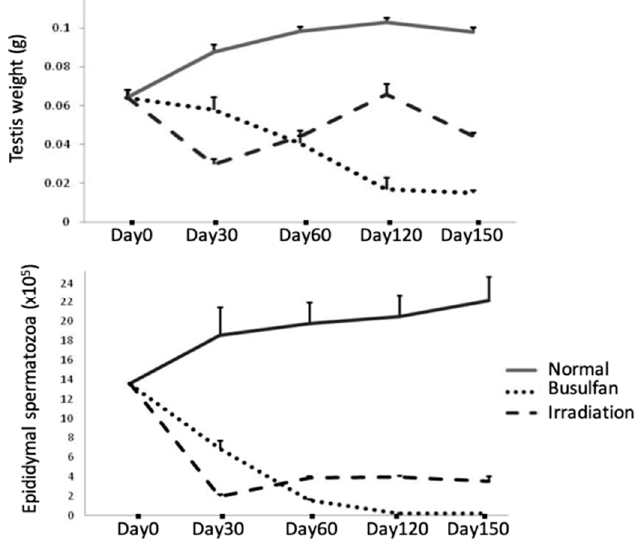
Figure 2. Testes weights and epididymal spermatozoa numbers in normal and busulfan-/irradiation- treated mice.